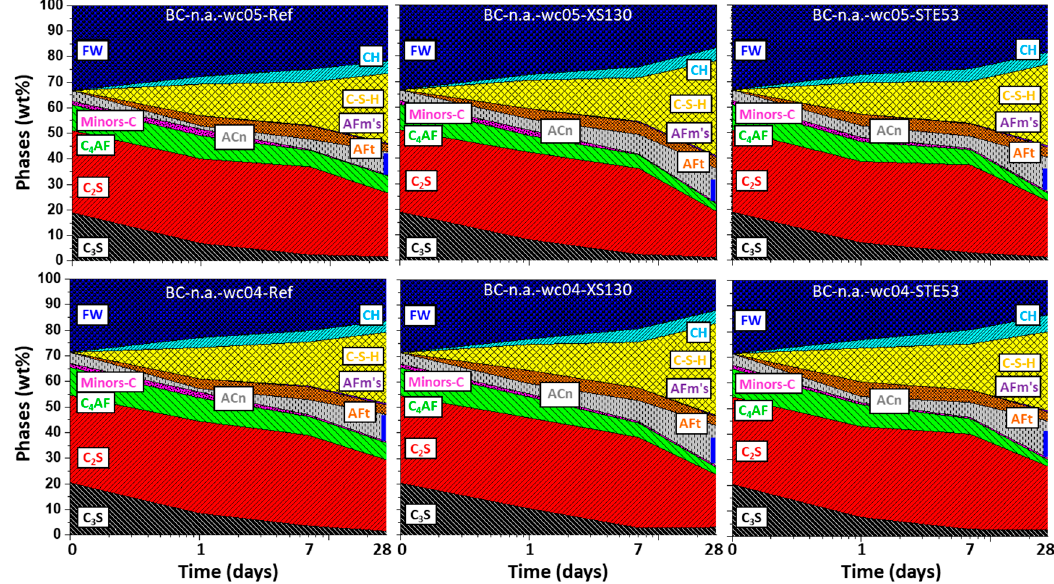
Figure 6. Phase development for BC-n.a. ( top ) w / c = 0.50, ( bottom ) w / c = 0.40, with all details as in Figure 5.